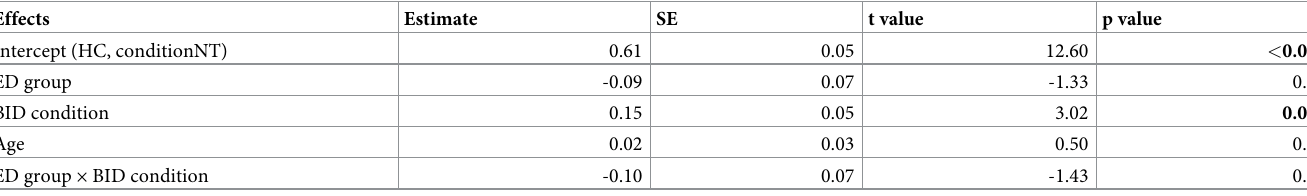
Table 9. Mixed effects linear regression analysis of learning rate parameter α .